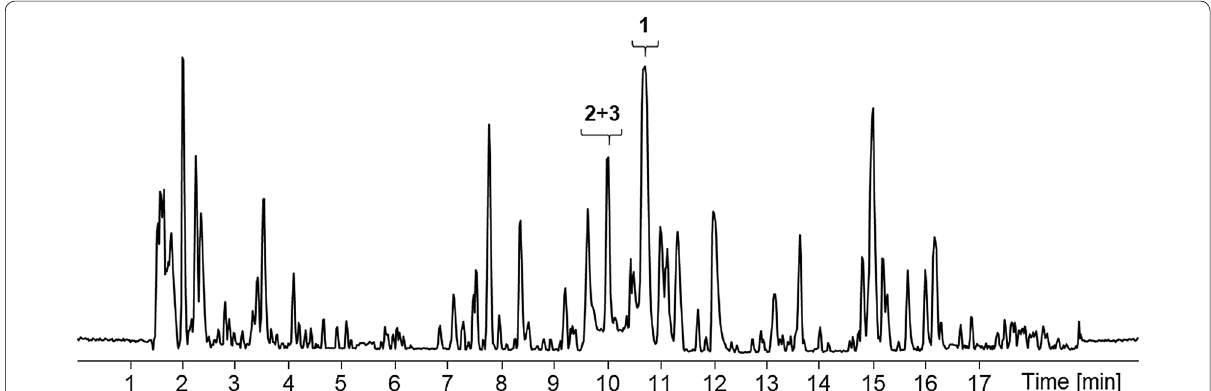
Fig. 1 Base peak chromatogram (LC-DAD-HRMS, ESI